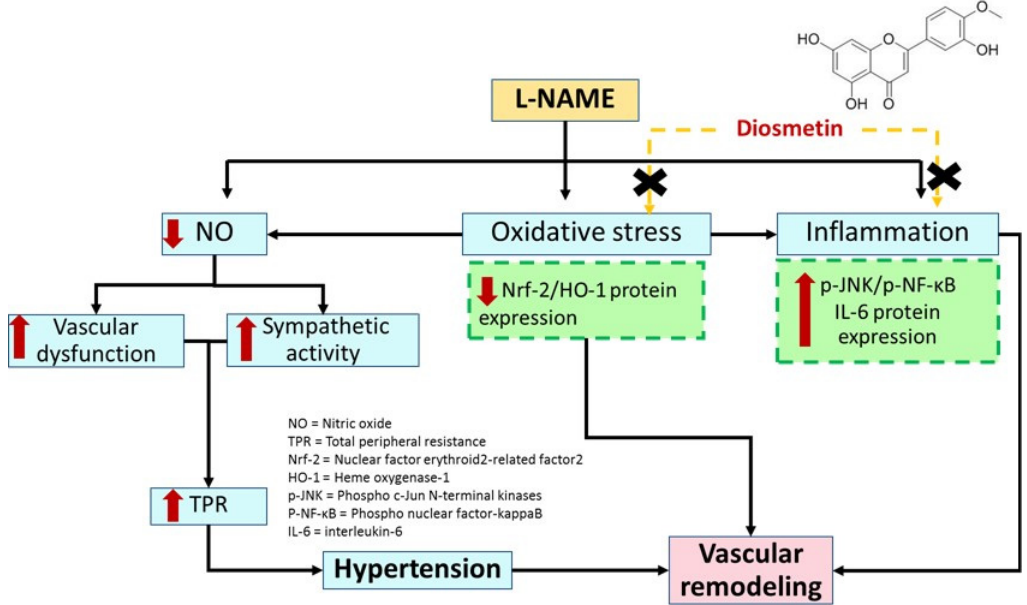
Figure 10. The possible mechanism action of diosmetin on vascular dysfunction and remodeling in L-NAME hypertensive rats.